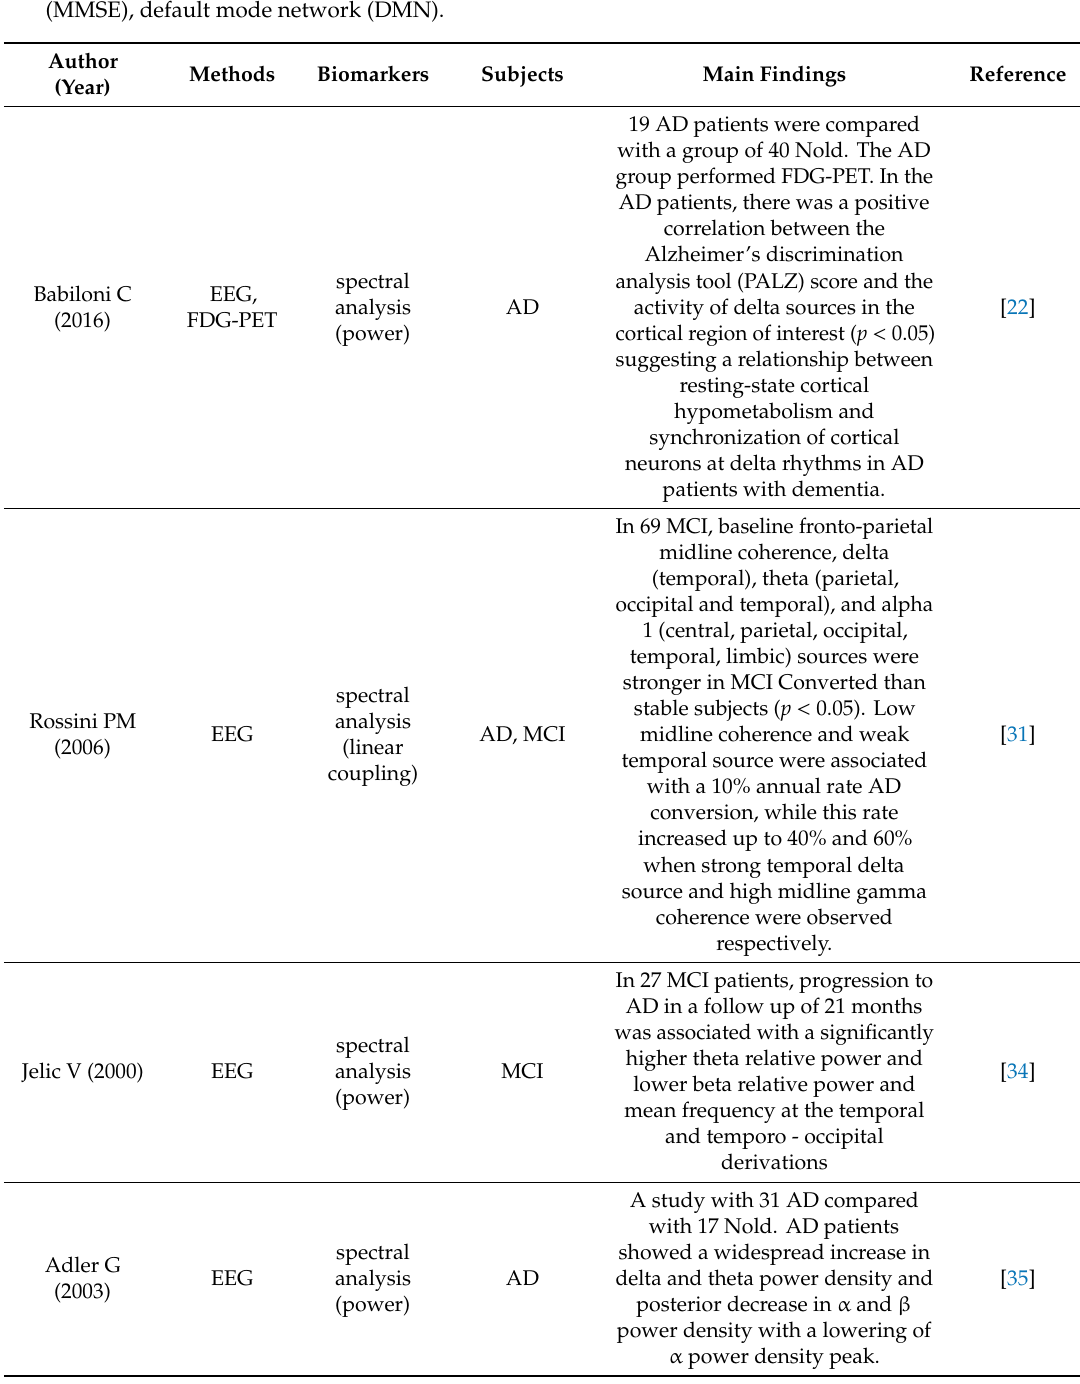
Table A1. Summary of the main studies that analyzed neurophysiological changes associated with the development of dementia. List of abbreviations: electroencephalography (EEG), fluorodeoxyglucose positron emission tomography (FDG–PET), mild cognitive impairment (MCI), Alzheimer’s disease (AD), normal elderly (Nold), Small Worldness (SW), transcranial magnetic stimulation (TMS), repetitive transcranial magnetic stimulation (rTMS), motor cortex (M1), Mini Mental State Examination (MMSE), default mode network